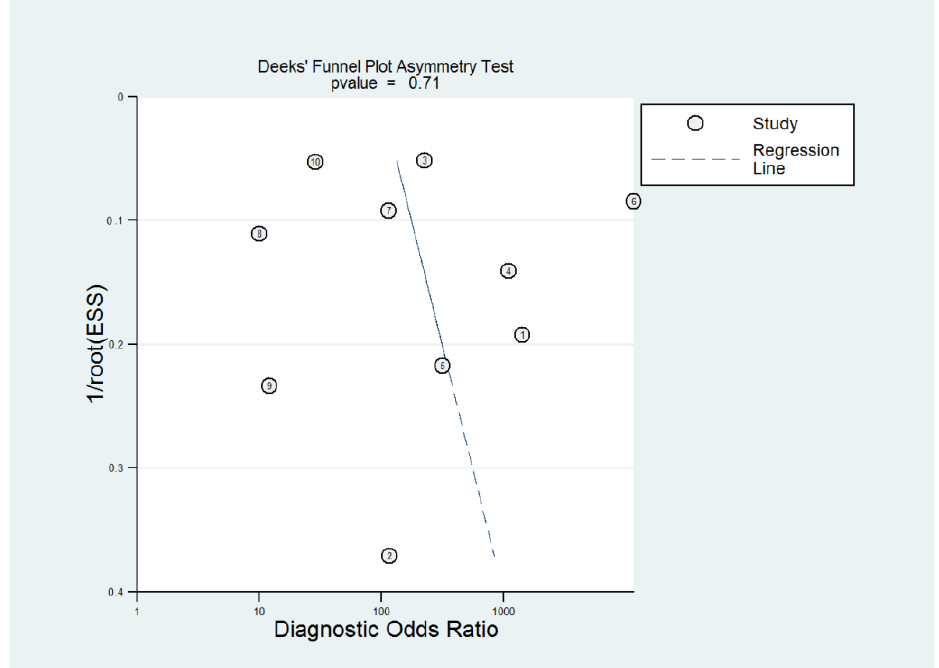
Figure 7. Fagan nomogram for two-dimensional transvaginal sonohysterography. It can be observed how the test changes the pre-test probability depending on a positive or negative result.